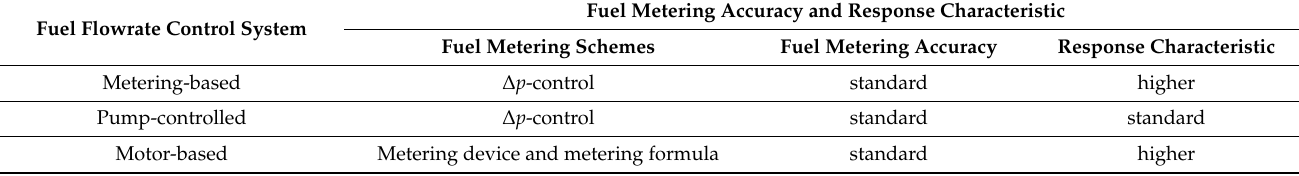
Table 4. Fuel metering accuracy and response characteristic.